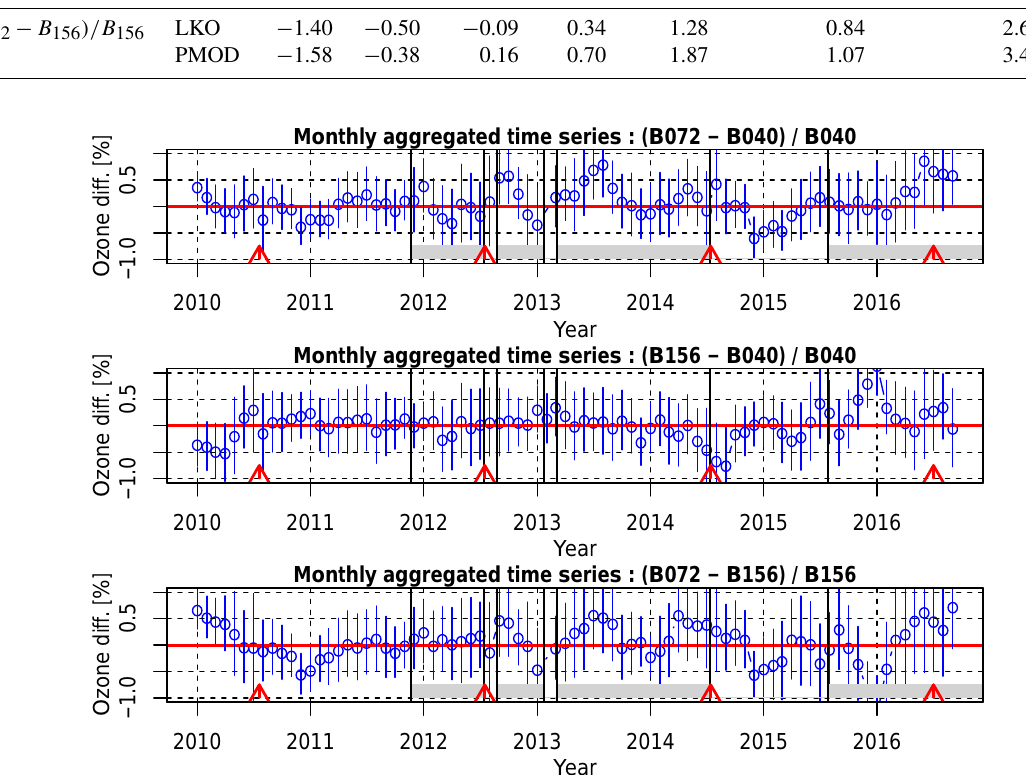
Figure 4. Time series of the monthly median differences of coincident ozone column measurements by pairs of Brewer instruments. The gray zones underline the periods when the Brewer B 072 instrument was located at Davos.The blue bars correspond to 1 SD.